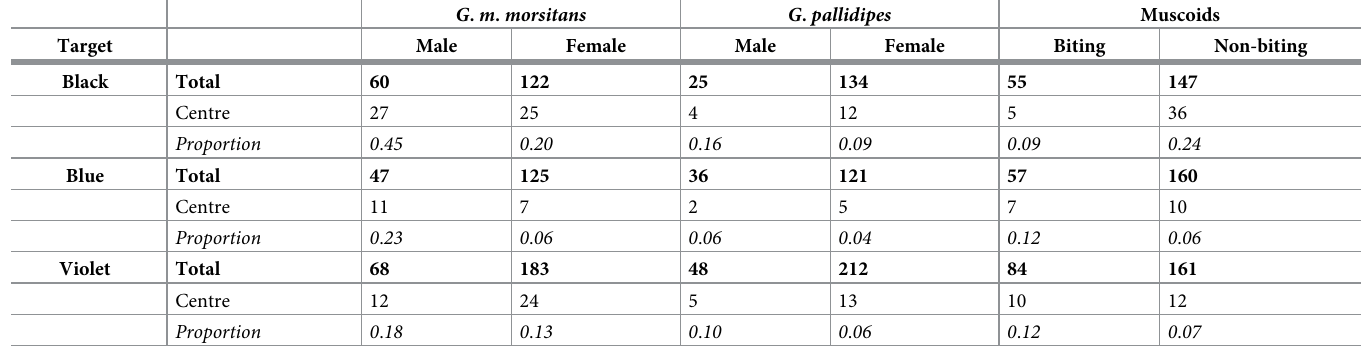
Table 4. Total numbers of flies caught over 21 sampling days of experiment 3, the number caught on the centre target panel, and that number expressed as a pro- portion of the total.